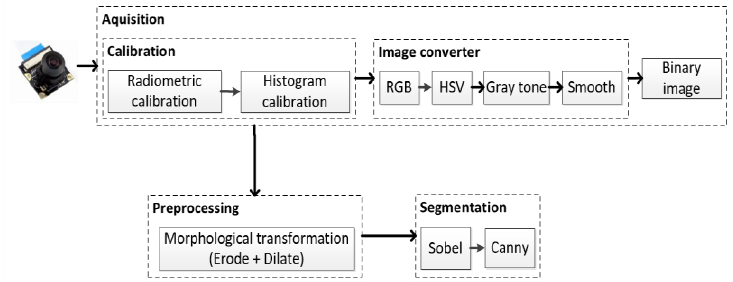
Figure 2. Visual marker recognition scheme.